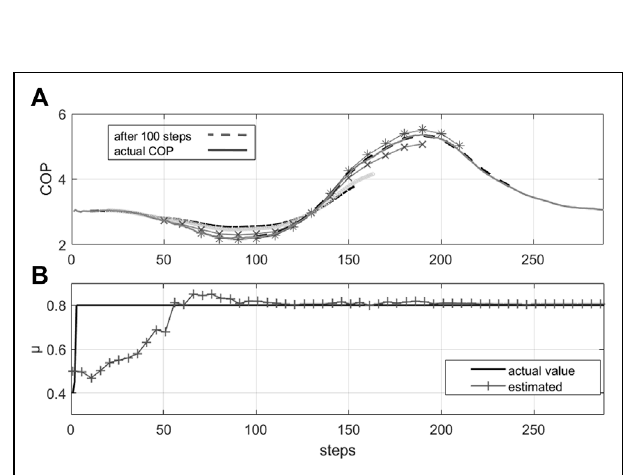
FIGURE 4 | Predictive capability analysis of the proposed COP predictors for 300 steps analysis (2.5 h).